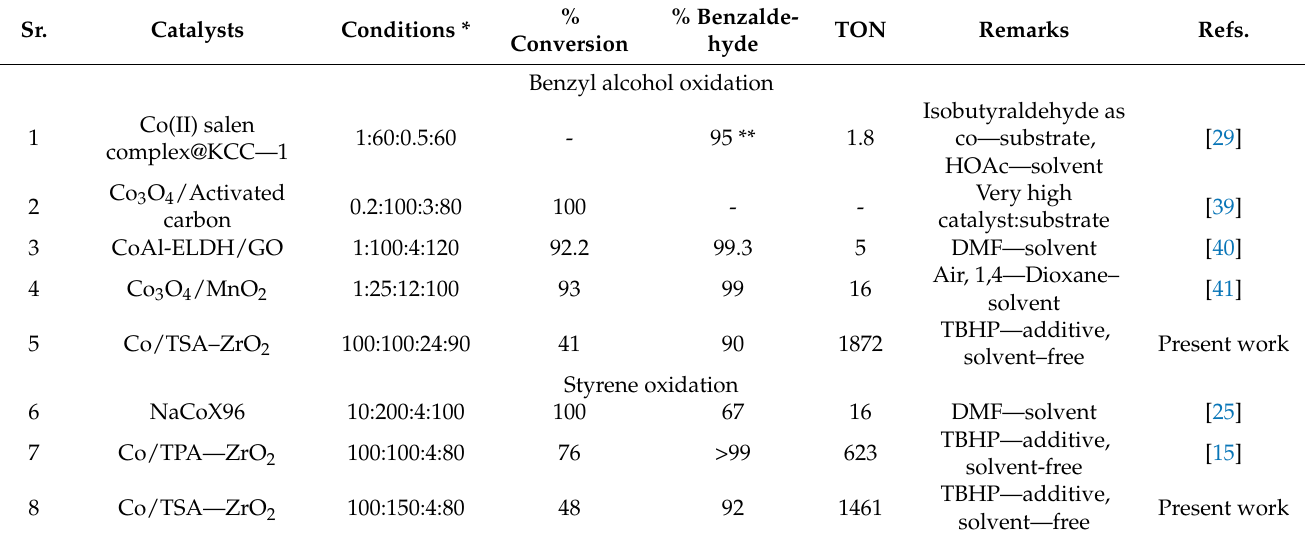
Table 2. Comparison of catalytic activity for aerobic oxidation of styrene with reported